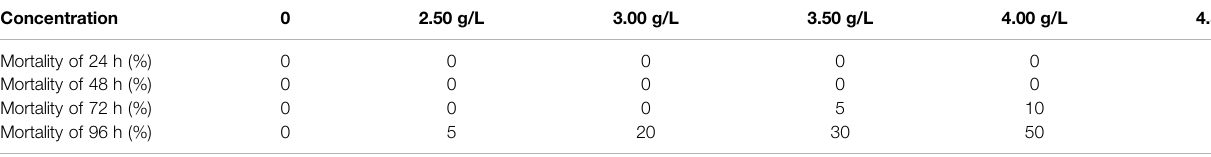
TABLE 1 | Mortality of each experimental group of semicarbazide in A. japonicas . Concentration